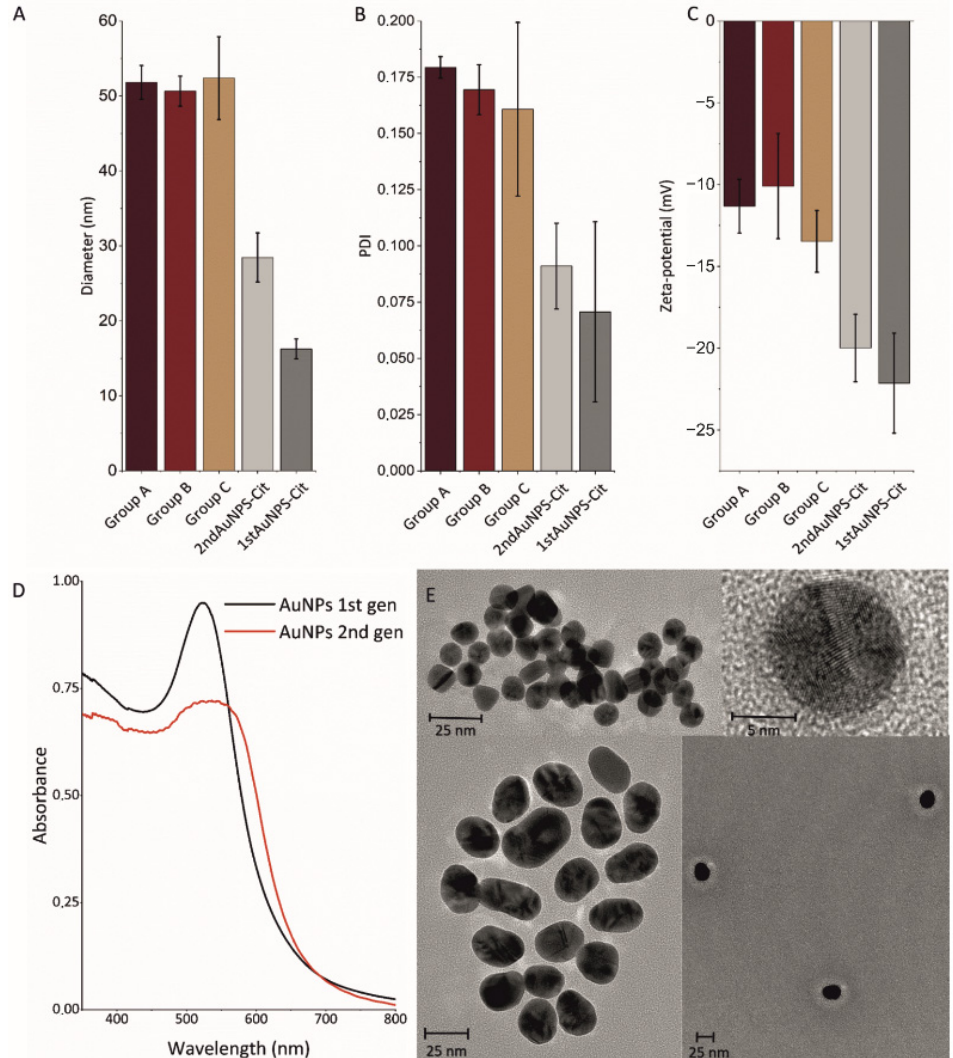
Figure 3. Characterization of AuNPs. Groups A, B and C are shown, along with 2nd gen citrate- stabilized AuNPs, and 1st gen citrate-stabilized AuNPs. ( A ) Mean diameter by intensity of the AuNPs, measured by DLS (n = 3). ( B ) Polydispersity indices (PDIs) derived from the DLS measurements (n = 3). ( C ) Zeta potentials measured by DLS (n = 2). ( D ) UV-VIS absorption spectra of 1st and 2nd generation citrate-stabilized AuNPs. ( E ) Transmission electron microscopy (TEM) pictures of 1st generation citrate-stabilized AuNPs (top) and second generation HS-PEG 5000 -coated AuNPs (bottom). In the bottom-right image, a pale corona around the AuNPs indicates successful PEG coating. By analyzing the TEM-images, an average size of 11.9 nm ± 0.8 nm (n = 113) for the first generation citrate-stabilized AuNPs (1) was found and for the second generation HS-PEG 5000 - coated AuNPs (4), an average size of 25.3 nm ± 2.1 nm (n = 201) was found.